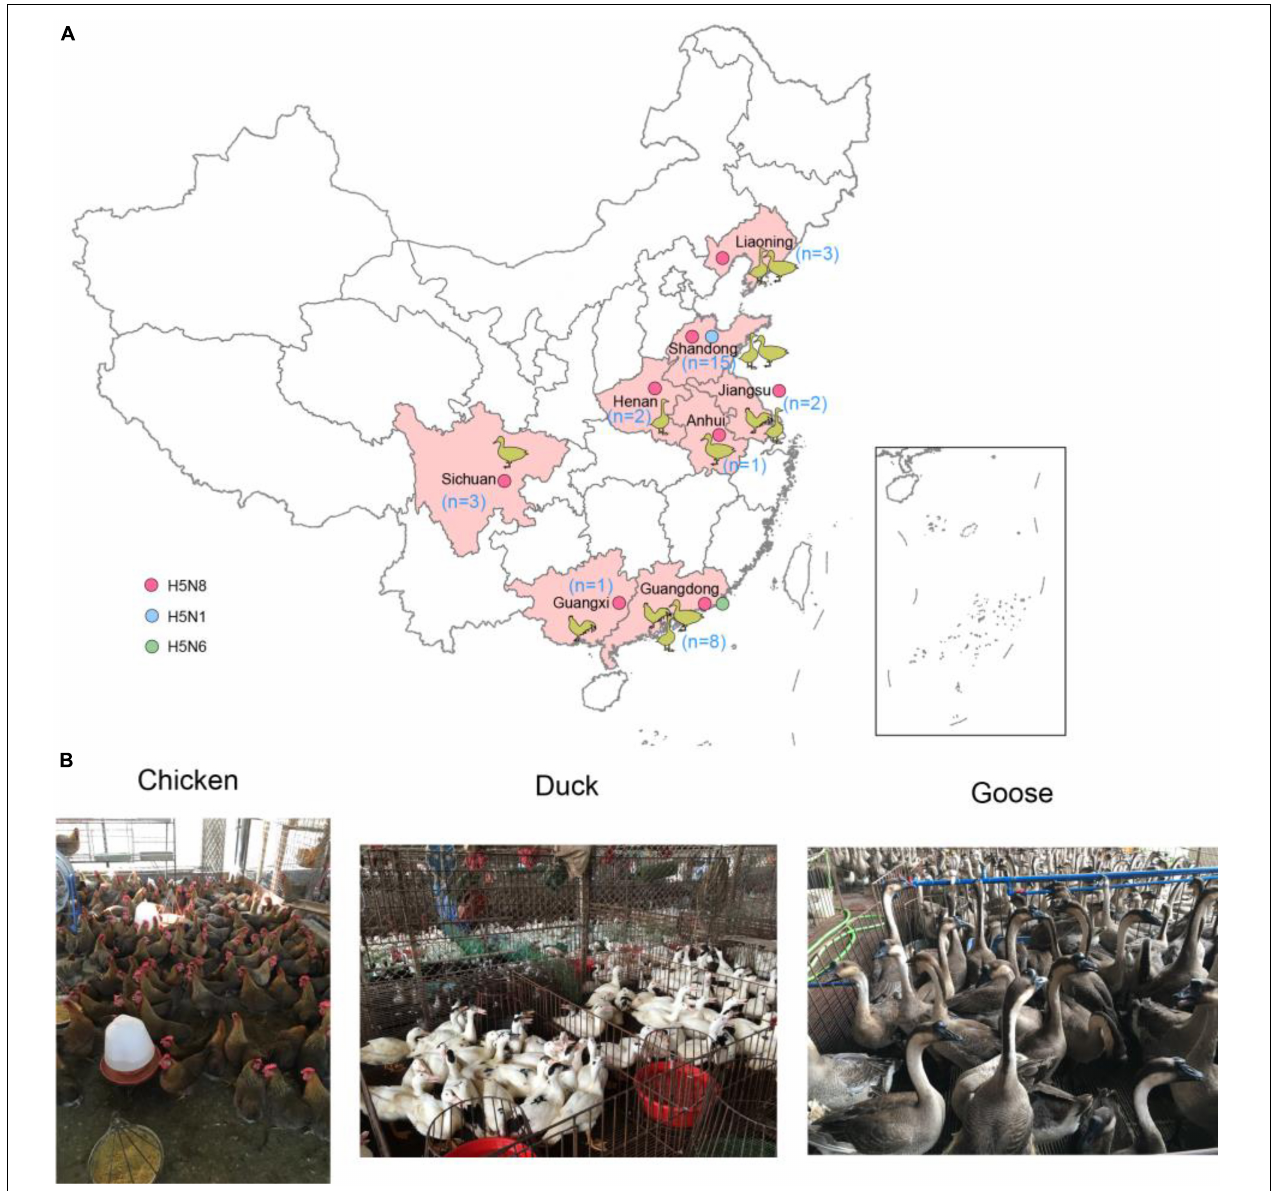
FIGURE 1 | Geographic distribution of H5 subtype influenza viruses isolated from chickens, ducks, and geese in China during January to August 2021 (A) and sampling picture in live poultry markets of China (B) . The animal cartoon in the map represents the host of H5 subtype viruses in different provinces of China in this study. The blue, green, and red dots represent H5N1, H5N6, and H5N8 viruses in this study. The map in the inset indicates islands in the South China Sea. The map was designed using ArcGIS Desktop 10.4 software